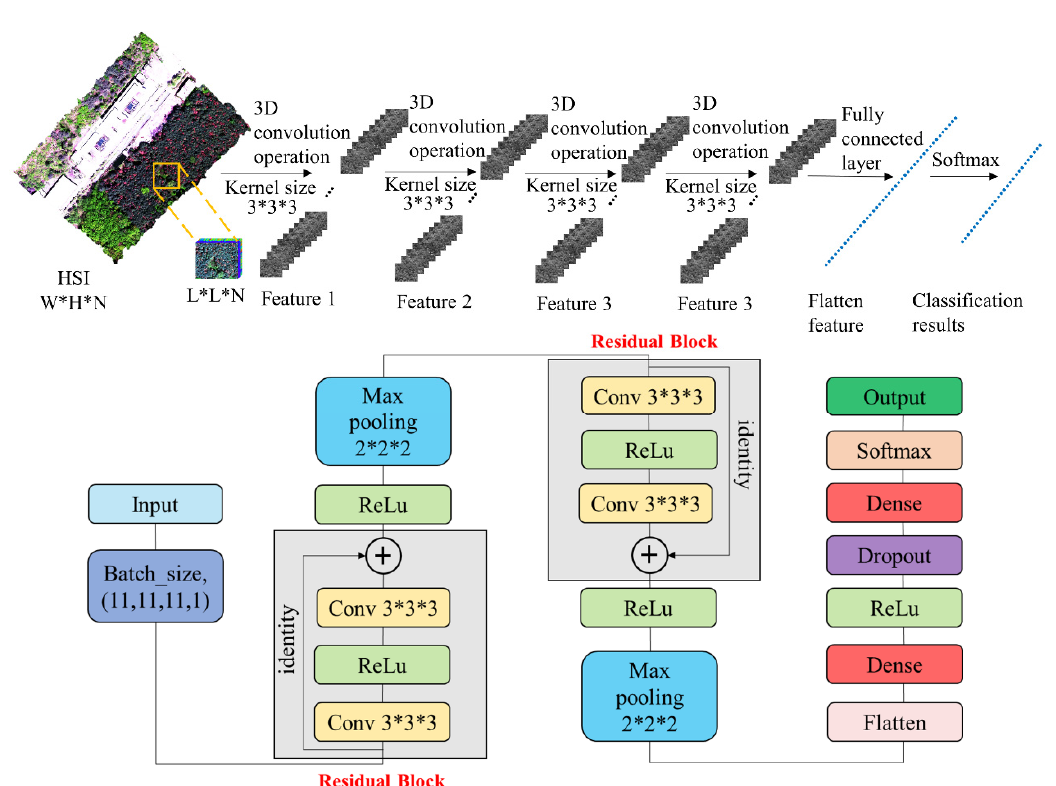
Figure 9. The architecture of the 3D-Res CNN model, which includes four convolution layers, two max pooling layers, and two residual blocks. Conv stands for convolutional layer, ReLu stand for the rectified linear unit.